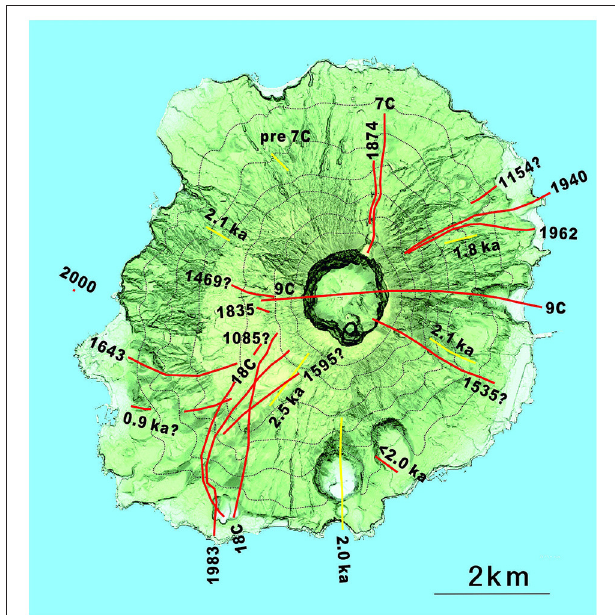
FIGURE 3 | Distribution of the eruption fissures within the last 2500 years. Red lines indicate the eruption fissures that erupted between the seventh century and the present. Yellow lines show the eruption fissures that erupted between 2500 years ago and the seventh